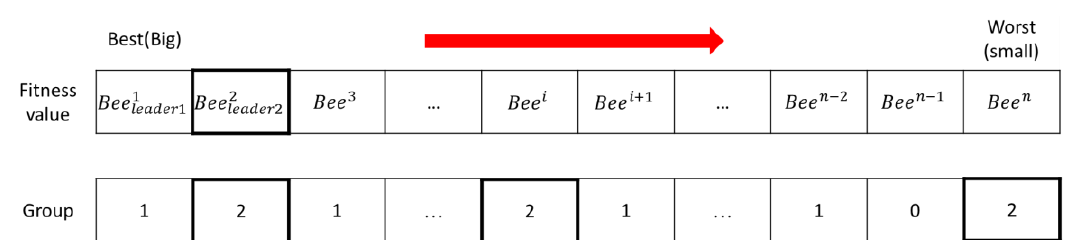
Figure 14. Second grouping of bees.